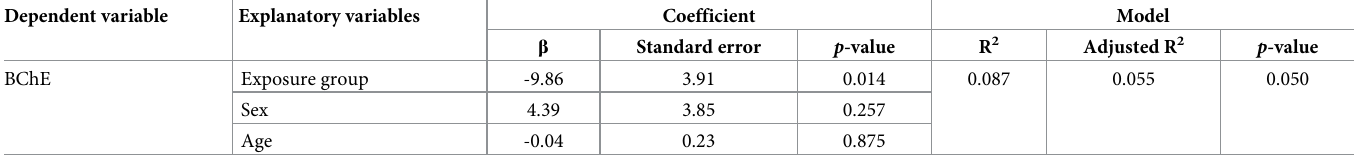
Table 4. Variables influencing BChE